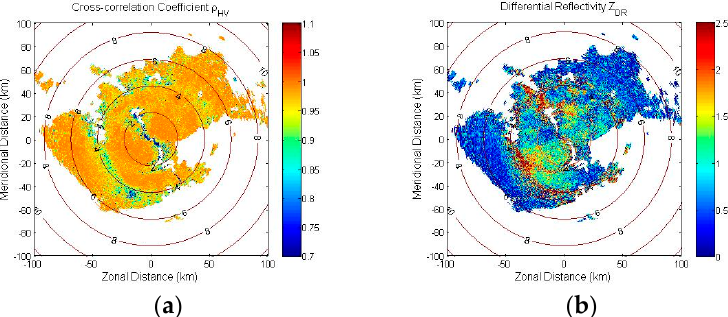
Figure 4. Dual-polarized radar PPI images of ( a ) ρ HV , and ( b ) Z DR at 05:45 UTC on 21st April 2014 with an elevation angle of 5°.